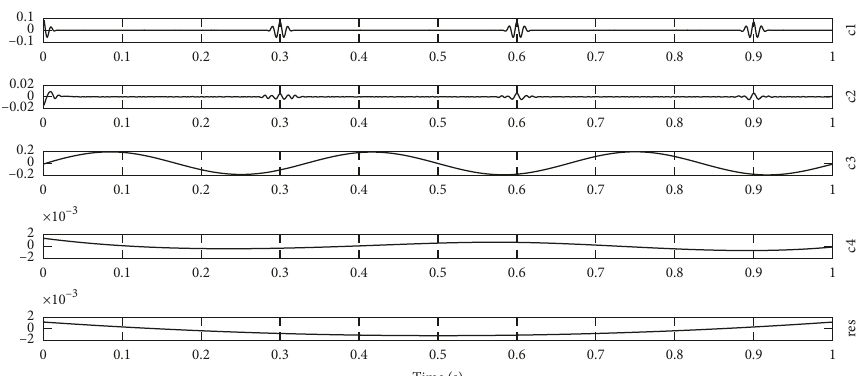
Figure 3: EEMD decomposition